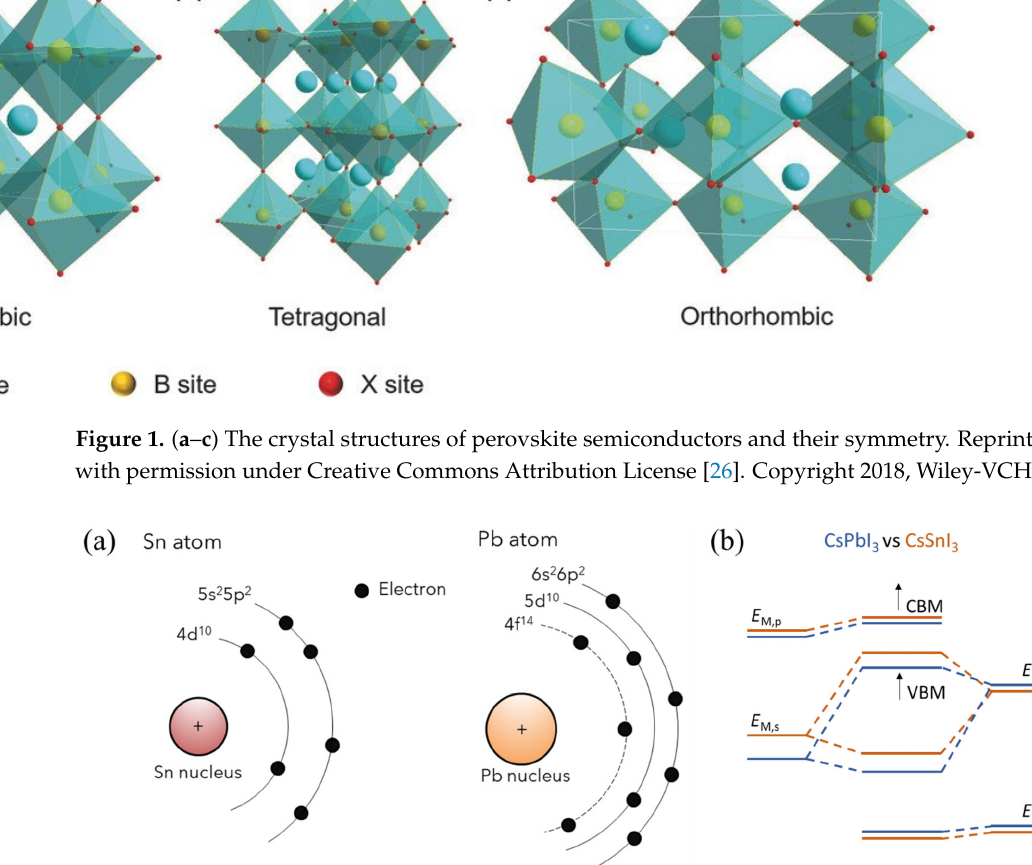
Figure 2. ( a ) Schematic diagram showing the lanthanide shrinkage in Sn and Pb atoms,